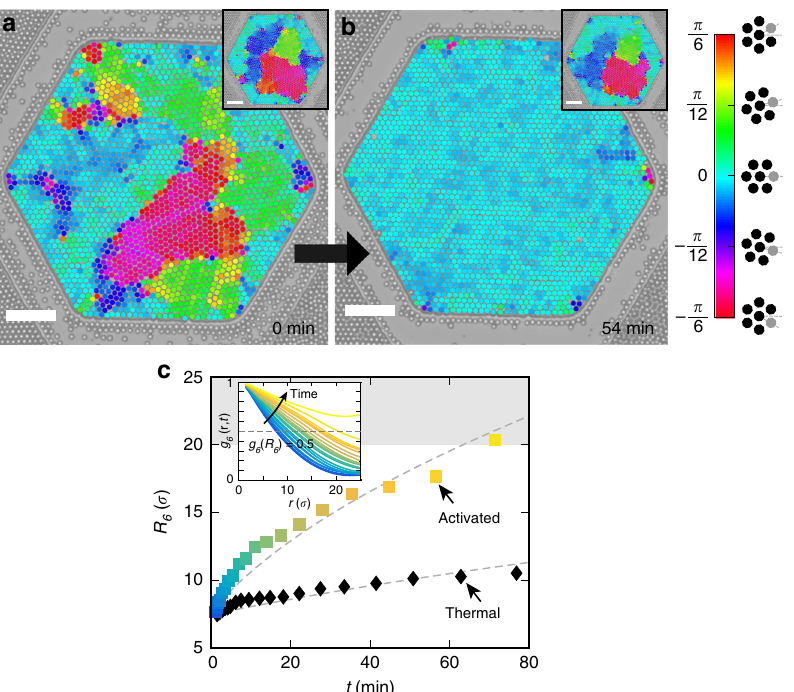
Fig. 1 Accelerated annealing. a , b Optical microscopy of a hexatic monolayer of passive beads (circles) containing a small fraction of active intruders (not visible at this magni fi cation). The passive beads are color-coded by the local orientational fi eld of the hexatic order. a The system is initially quenched in adjacent polycristallites and b rapidly relaxes towards an ordered monolayer, following the activation of the self-propelled particles in the layer. The thermal experiment, in the absence of active particles, is signi fi cantly slower and shows little evolution within the same time-span (insets). Scale bars, 50 μ m. c (inset) Bond orientational correlation function g 6 ( r , t ) as a function of distance r and for increasing times t (blue to yellow color gradient) (see main text). It increases with time as long-range order develops: large grains grow at the expense of smaller ones. c Time-evolution of the characteristic grain radius R 6 , in units of colloid diameters σ , de fi ned from g 6 ( R 6 , t ) = 0.5 for thermal (black) monolayer or in the presence of embedded self-propelled particles (color, V = 10 μ m s − 1 , α = 1.3%) and fi t by a normal grain-growth R 6 ( t ) 2 = R 6 (0) 2 + γ t (dotted lines, see Main text). The gray area delimits grain sizes >20 σ ,